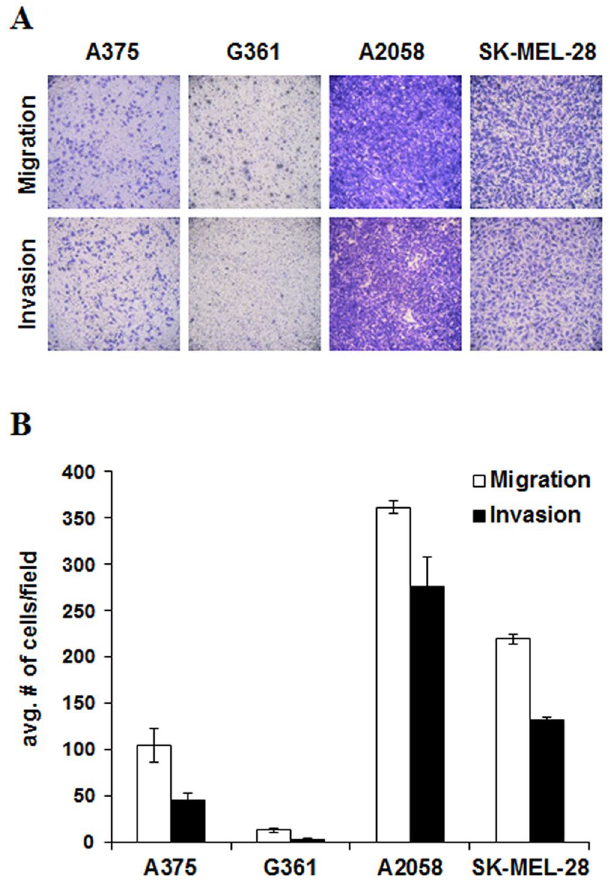
Figure 4. The migratory and invasive potential of the melanoma cell lines (A375, G361, A2058, and SK- MEL-28). ( A ) Represented images of migrated and invaded cells and ( B ) quantified data (mean ± SEM) from three independent